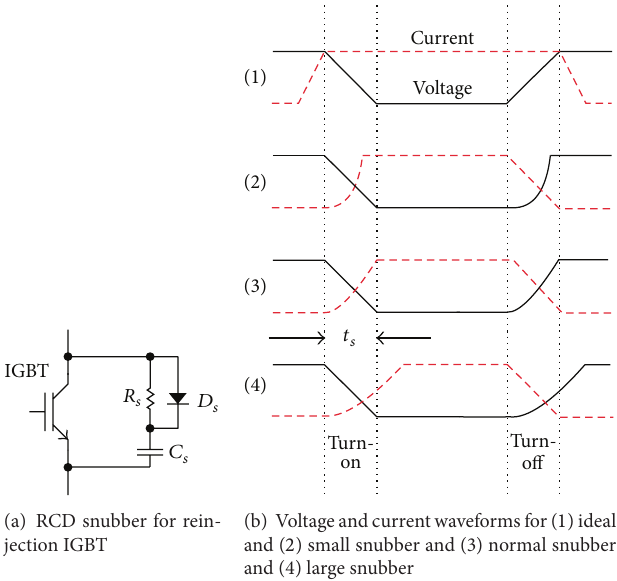
Figure 10: Snubber consideration for reinjection